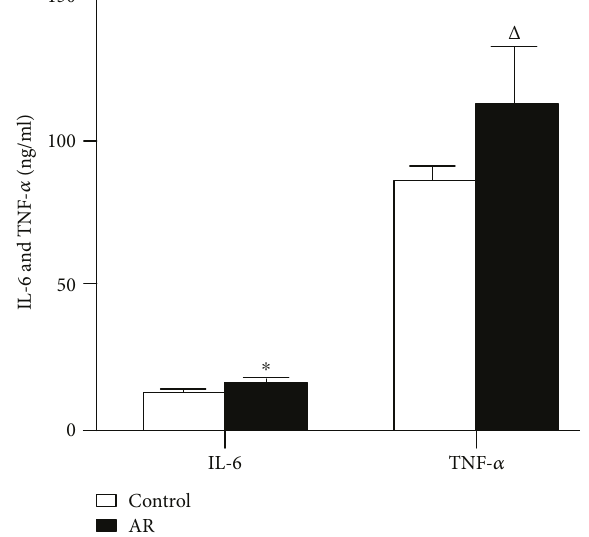
Figure 4: Levels of IL-6 and TNF-a, determined by ELISA. Comparing between in the AR model group and the control group. Data are expressed as mean ± SD; ∗ P < 0 01 , △ P < 0 05 ; n = 8